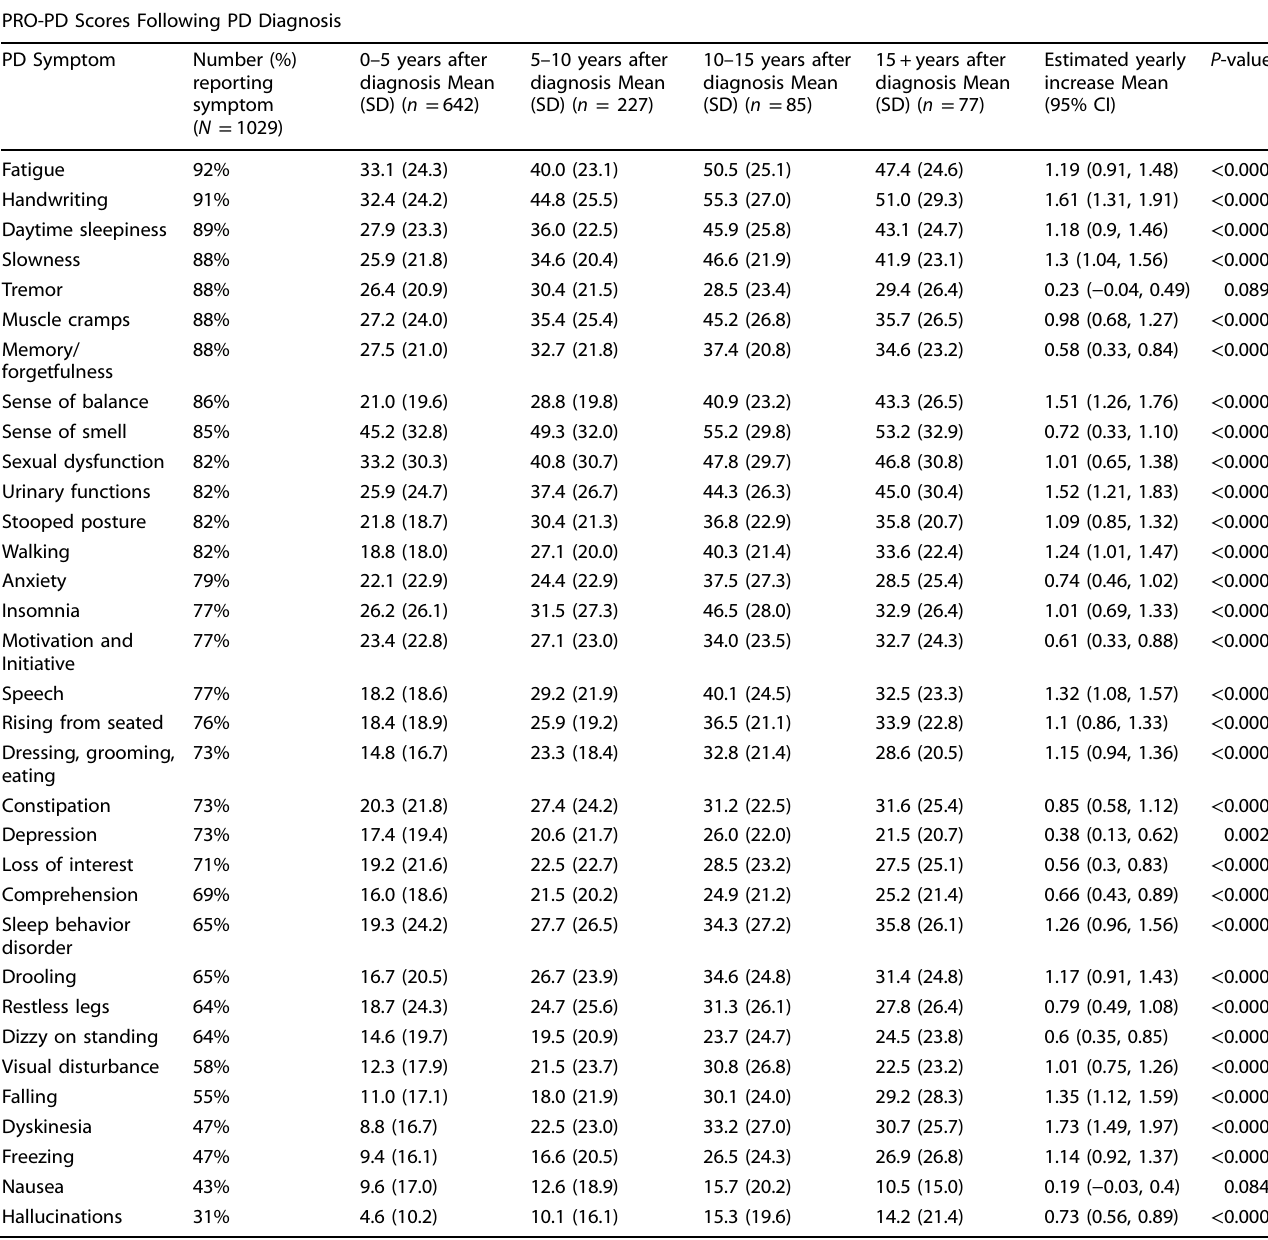
Table 2. PRO-PD severity by symptom and years since